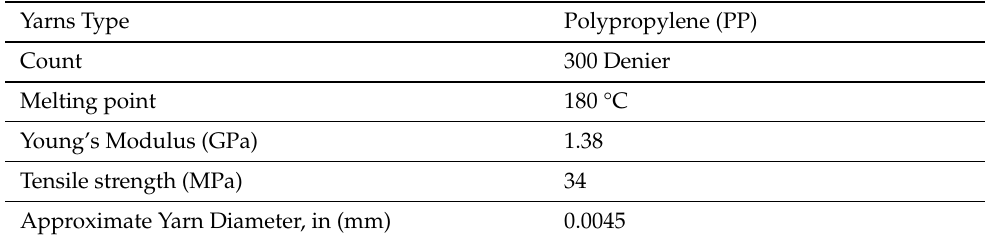
Table 4. Polypropylene yarns specs